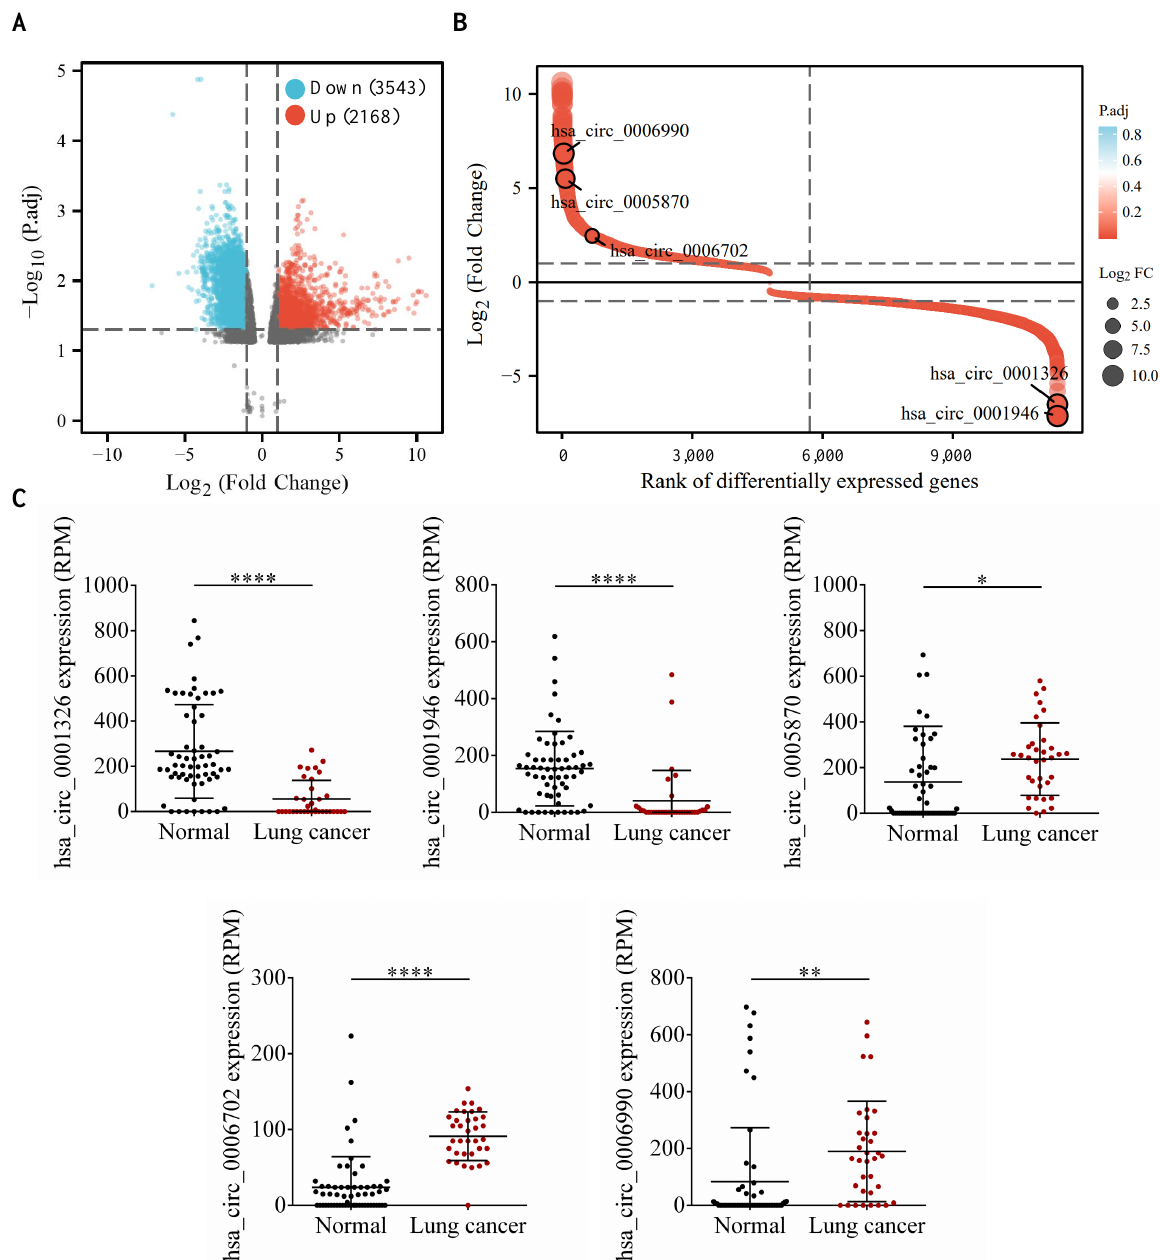
Figure 7. Identification and analysis of circRNAs from TCGA and GEO database. ( A ) Volcano plot shows the profile of differentially expressed circRNAs between the healthy volunteers and NSCLC patients from TCGA and GEO databases. ( B ) has_circ_0006990, hsa_circ_0005870, hsa_circ_0006702, hsa_circ_0001326, and hsa_circ_0001946 are screened by robust rank aggregation. ( C ) The relative expression of these DE-circRNAs is further verified. * p < 0.05; ** p < 0.01; **** p <